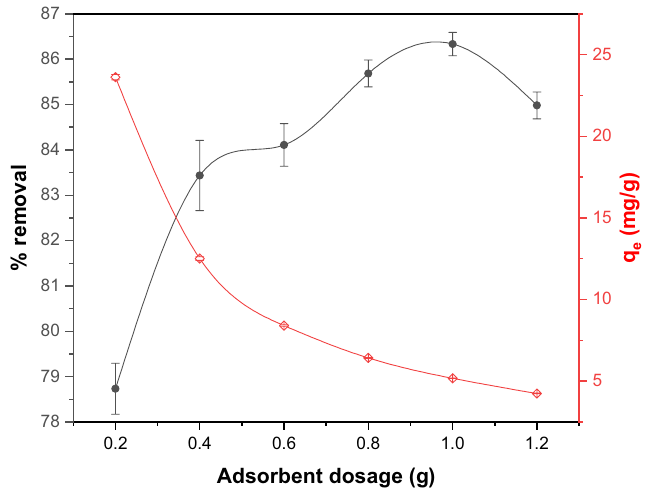
Figure 8. Effect of adsorbent dosage on adsorptive CR removal using GSC WCO .